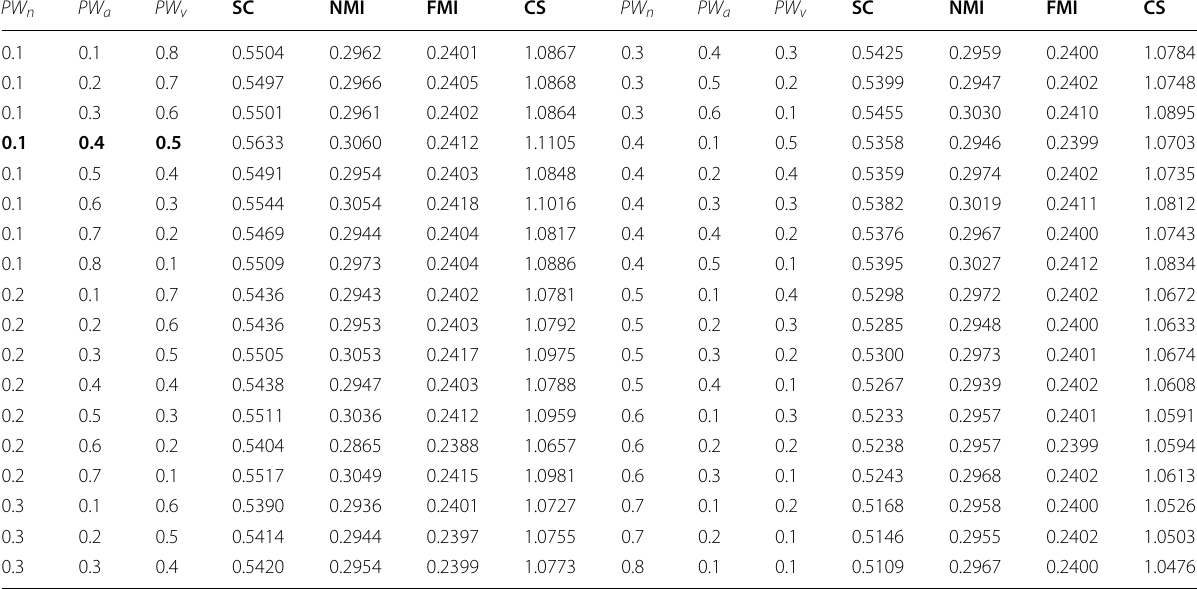
Table 2 Influence of